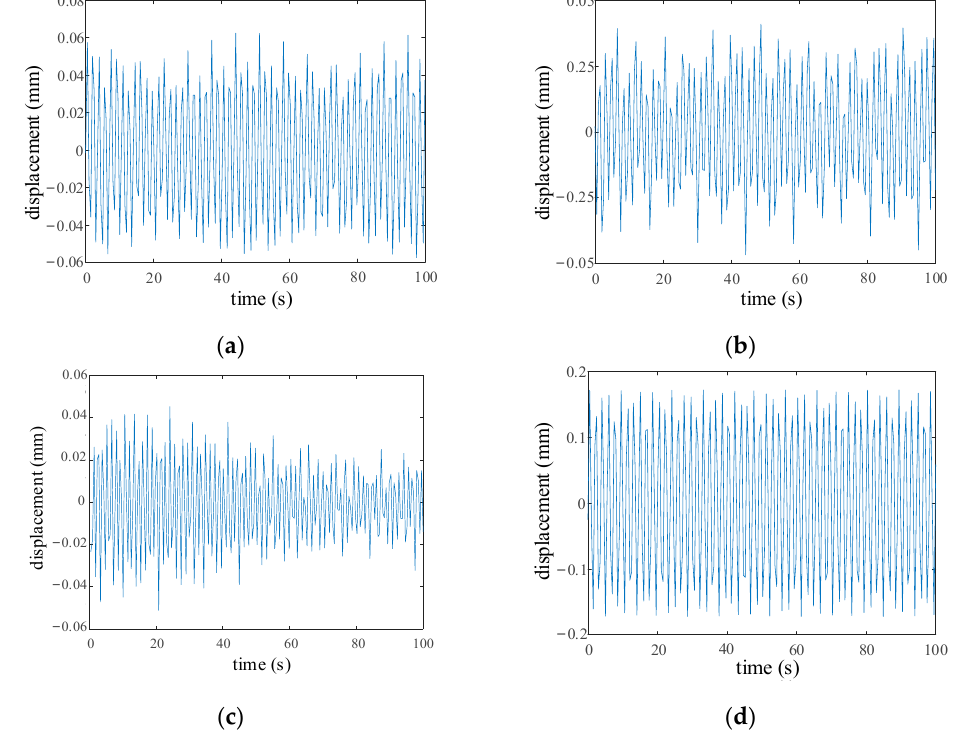
Figure 8. The time domain response of some components in the third stage. ( a ) Horizontal displace- ment H s3 ; ( b ) rotation displacement u p33 ; ( c ) vertical displacement Y c3 of the carrier; ( d ) rotation dis- placement u c3 of the carrier.